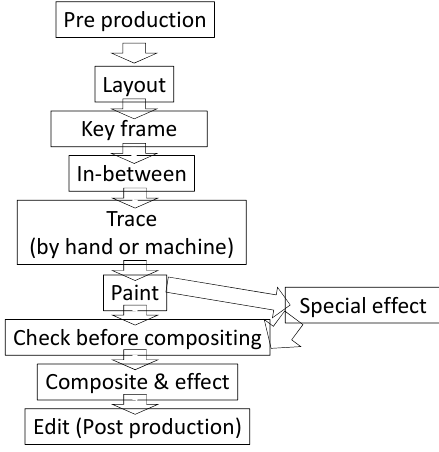
Figure 1. Main production